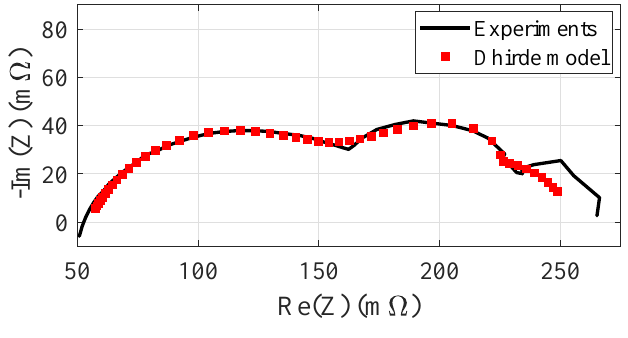
Figure 11. Dataset B. Fuel starvation.